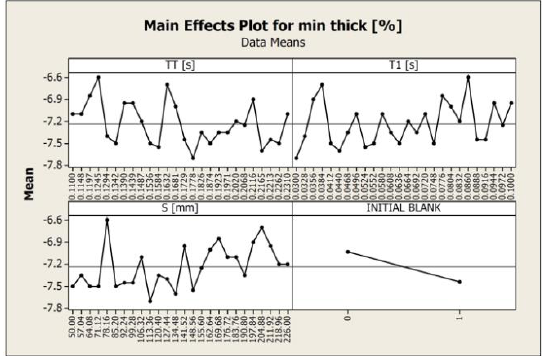
Figure 17. MEP for max thick % output.